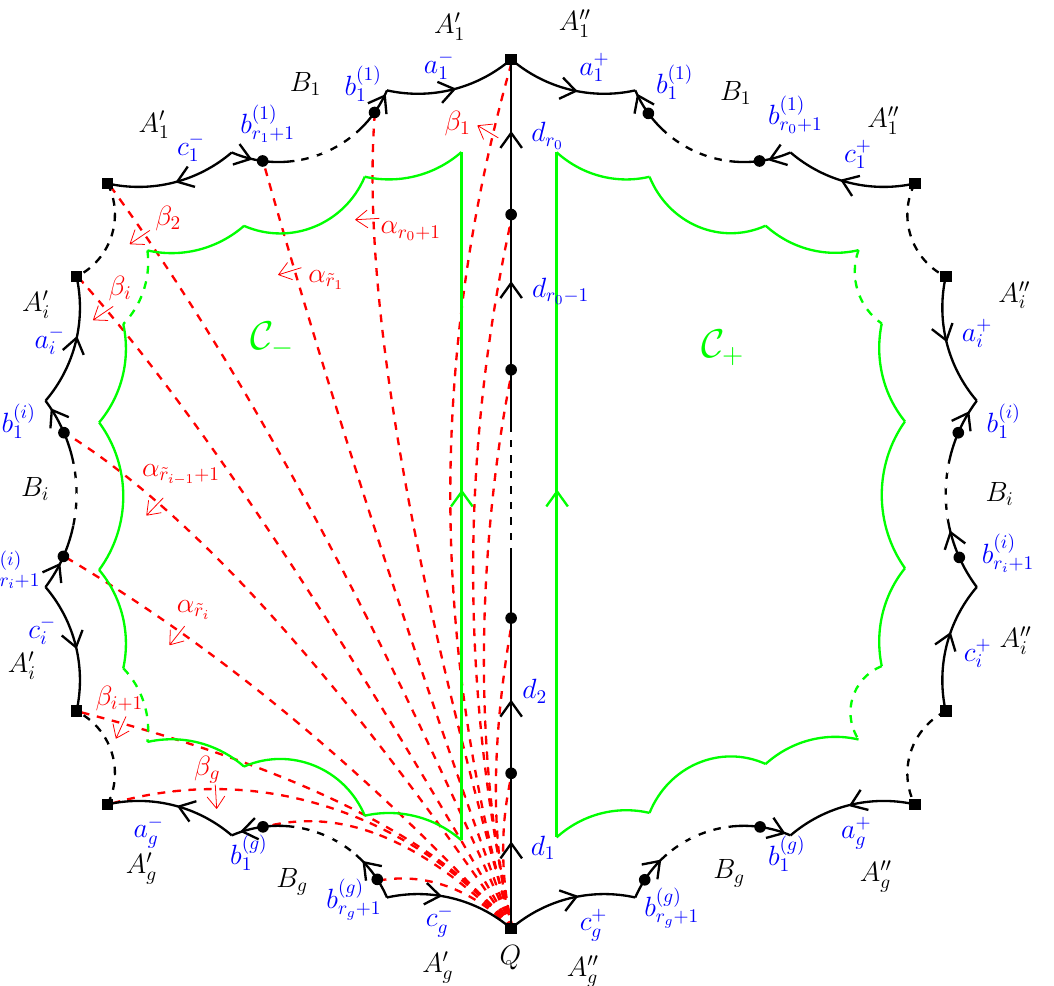
Figure 10. Cycles and local system for the generic non-planar relations on a genus- g surface.